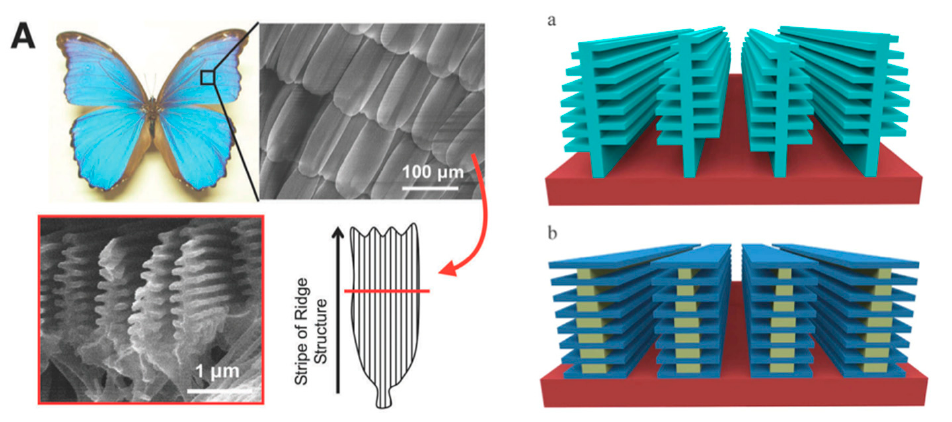
Figure 2. ( A ) Schematic representation of the scales of morpho butterfly wings. ( a ) Christmas tree structure of lamellar layers similar to actual wing scales. ( b ) Designed scales to be fabricated with aligned lamellae structures of PMMA/LOR (LOR; lift ‐ of ‐ resist supplied by MicroChem Corp.) alternate layers. From ref. [12].